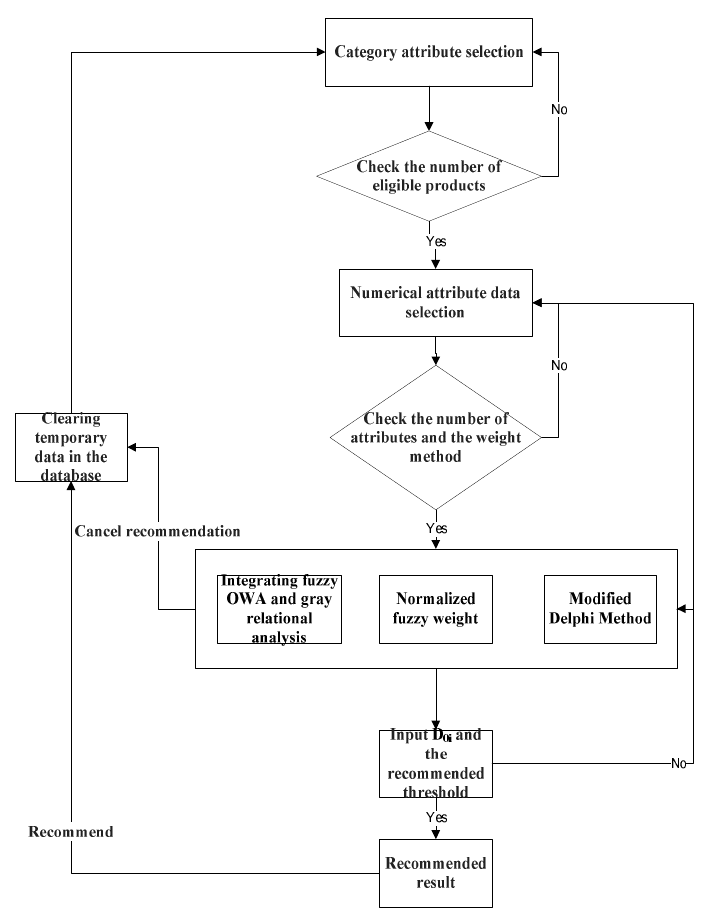
Figure 1. The research process. OWA, ordered weighted averaging.